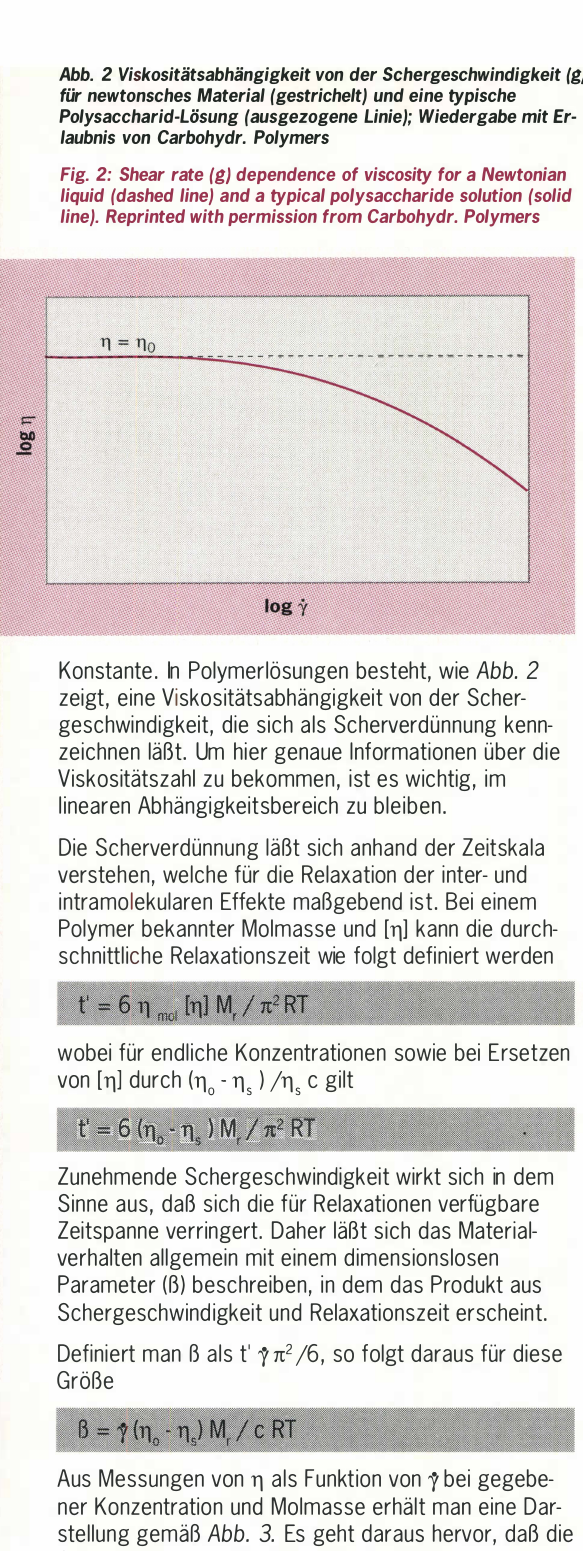
Fig. 3: Fractional decrease in viscosity with increases in generalised shear rate, for various molecular weight fractions of guar galacto­ mannan. Reprinted with per­ mission from Carbohydr.